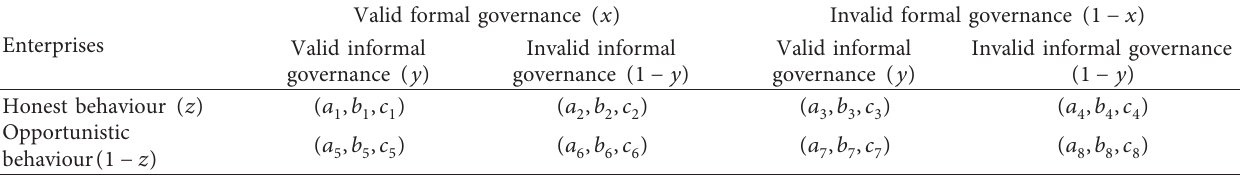
Table 1: The payoff matrix for the game’s three sides.